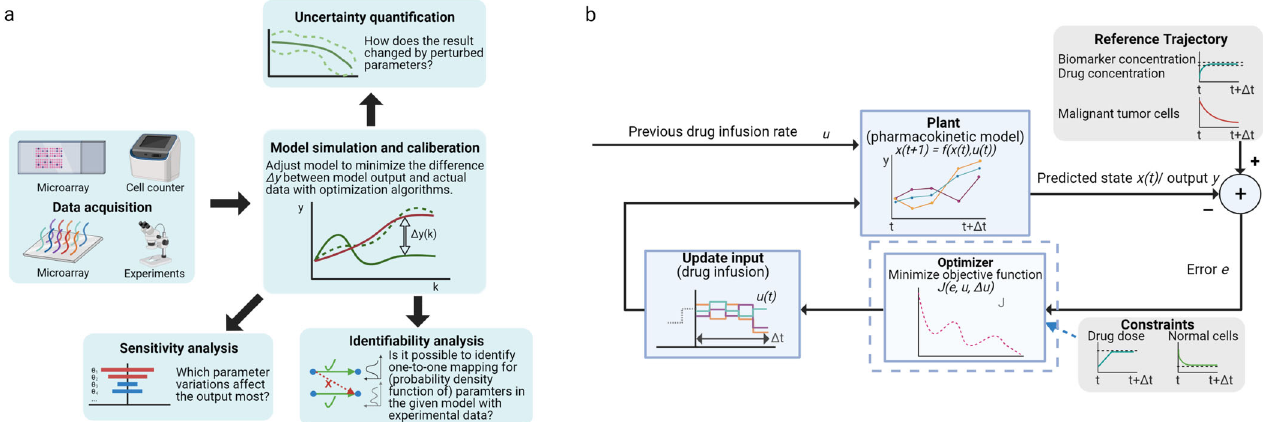
Fig. 7 Dynamic modeling and analyses. a Scheme of parameter estimation. After data acquisition, parameters are fi tted in models by minimizing the difference between experimental data and model output. Sensitivity analysis, uncertainty quanti fi cation and identi fi ability analysis help assess the performance and robustness of the fi t. b Loop of Model Predictive Control. Based on the output of model prediction, this control strategy updates control input (e.g., drug administration) to make the system dynamics track reference trajectory (e.g., desired tumor cell decrement) during each time interval. Its essence is to handle the constrained optimization problem (Constraints can be maximal drug doses and minimal normal cell